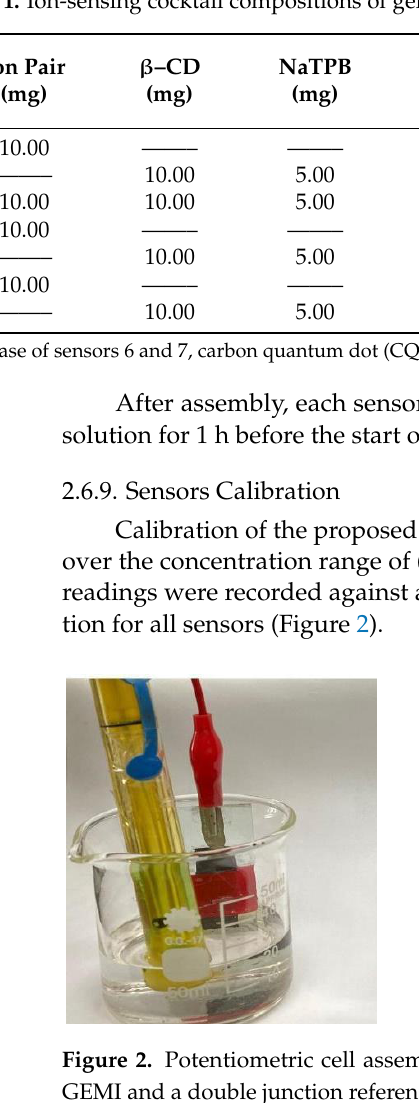
Table 1. Ion-sensing cocktail compositions of gemifloxacin (GEMI) screen-printed sensors. Amounts of Each